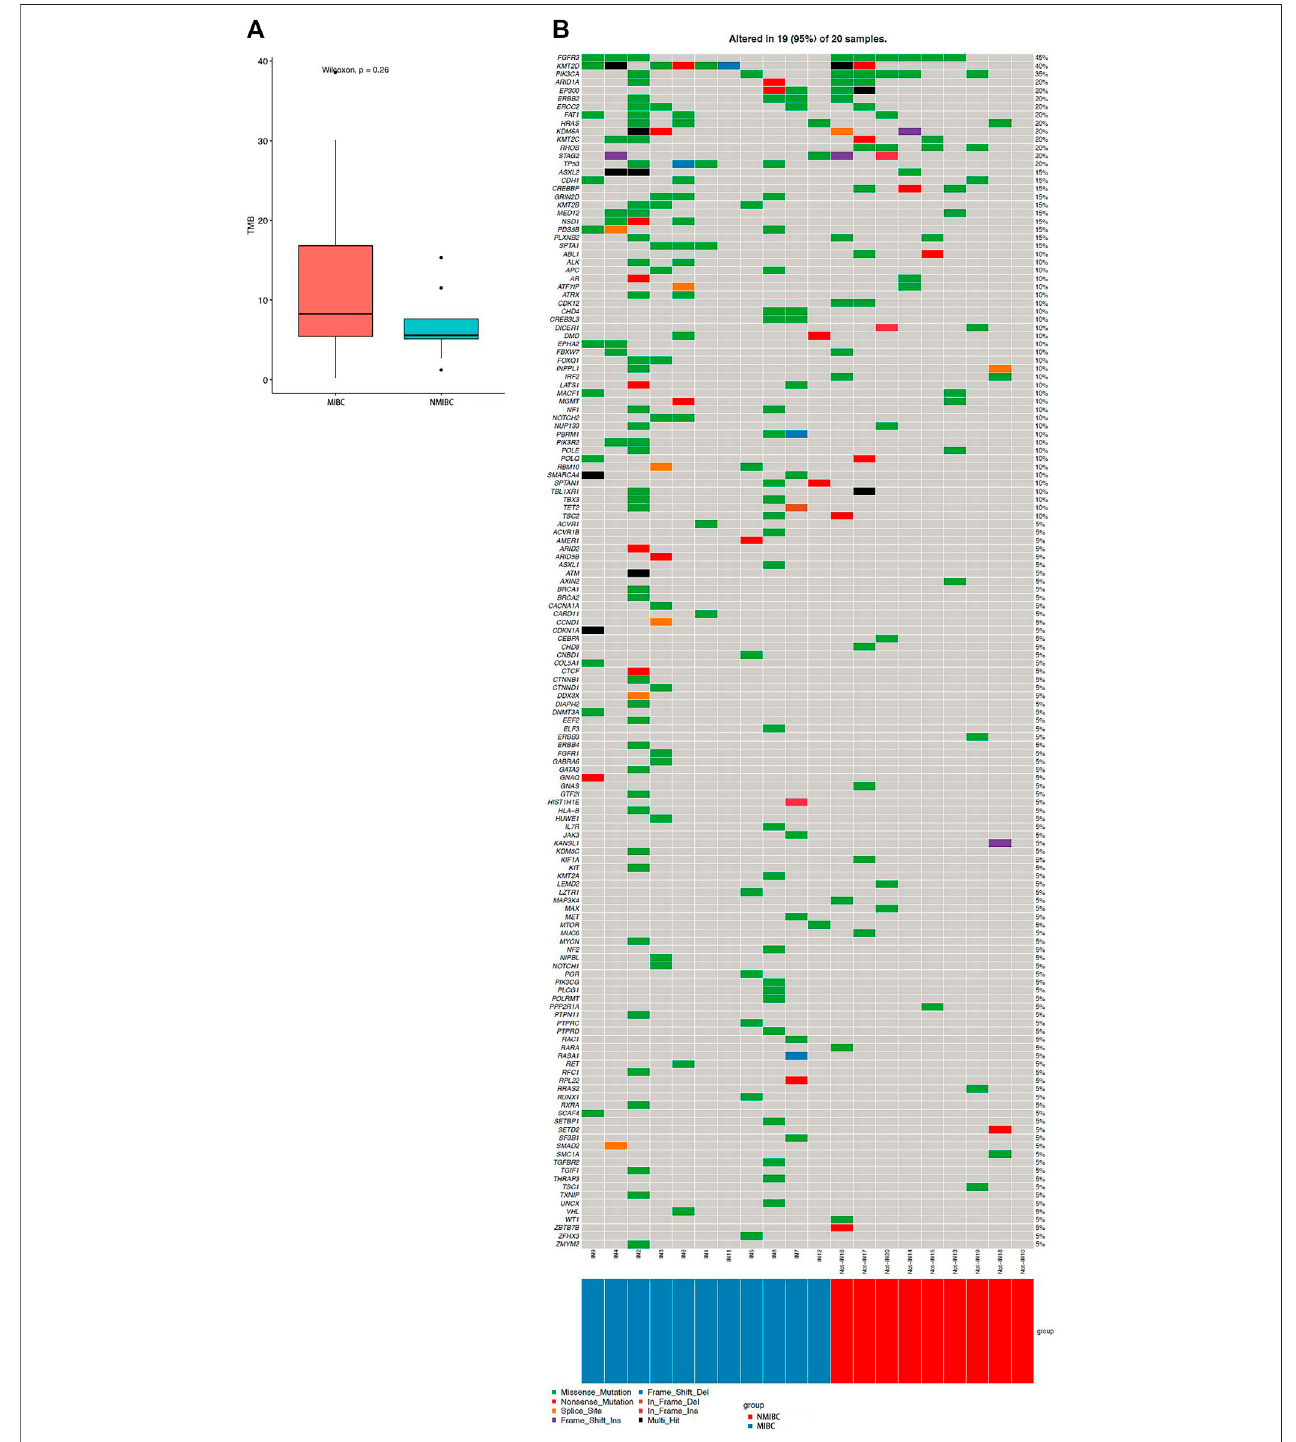
FIGURE1 | TMB and driver gene mutation pro fi les ofbladder cancer. (A) TMB level in MIBC and NMIBC. Datawere expressed asmedian (interquartile range) and were statistically analyzed by Mann-Whitney U test; (B) The driver gene mutation pro fi les in 20 bladder cancer samples. TMB: tumor mutation burden; NMIBC: non-muscle invasive bladder cancer; MIBC: muscle-invasive bladder cancer.